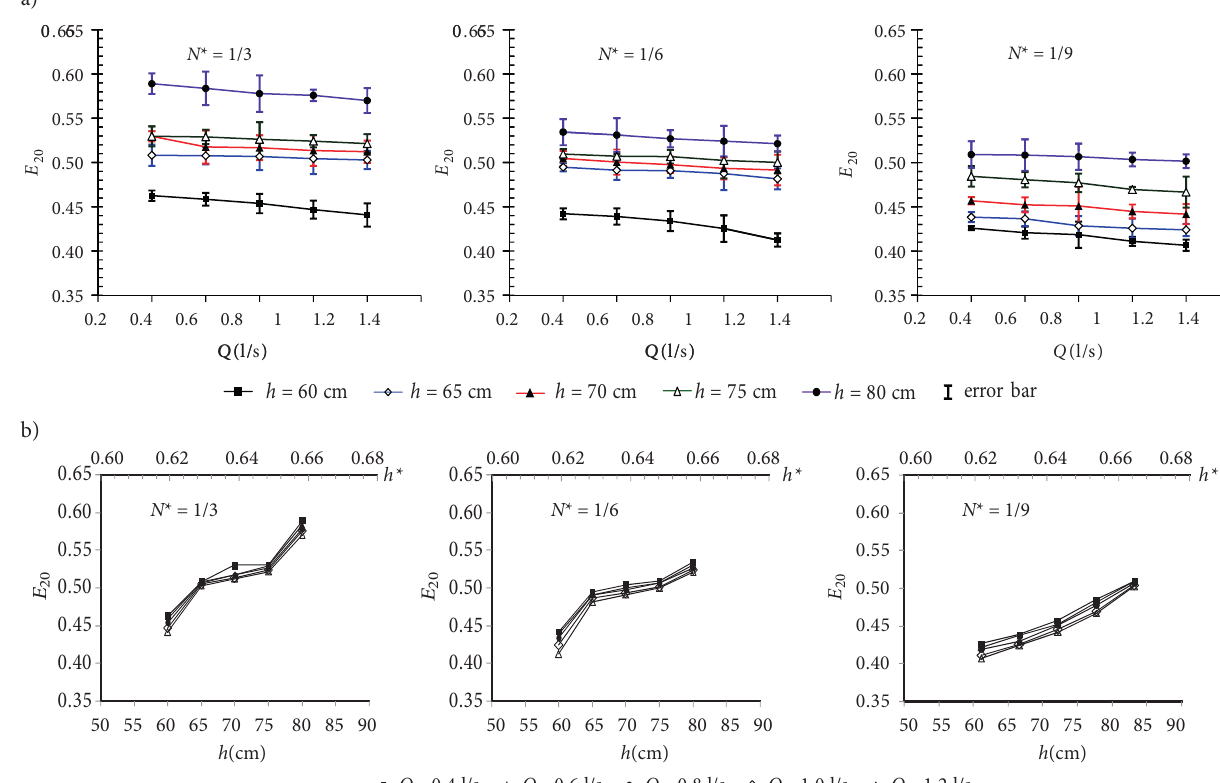
in parallel flashboard spillways: (a) E 20